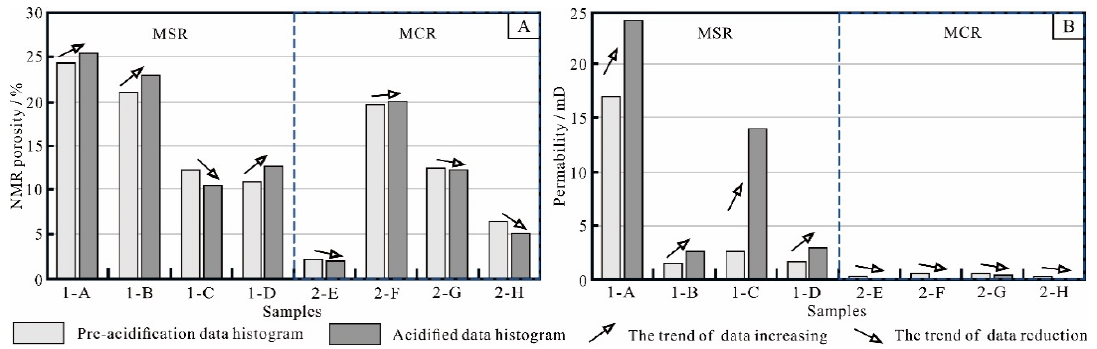
Figure 16. The histogram of NMR experimental parameters. ( A ) NMR porosity, %; ( B ) Permeability, mD.